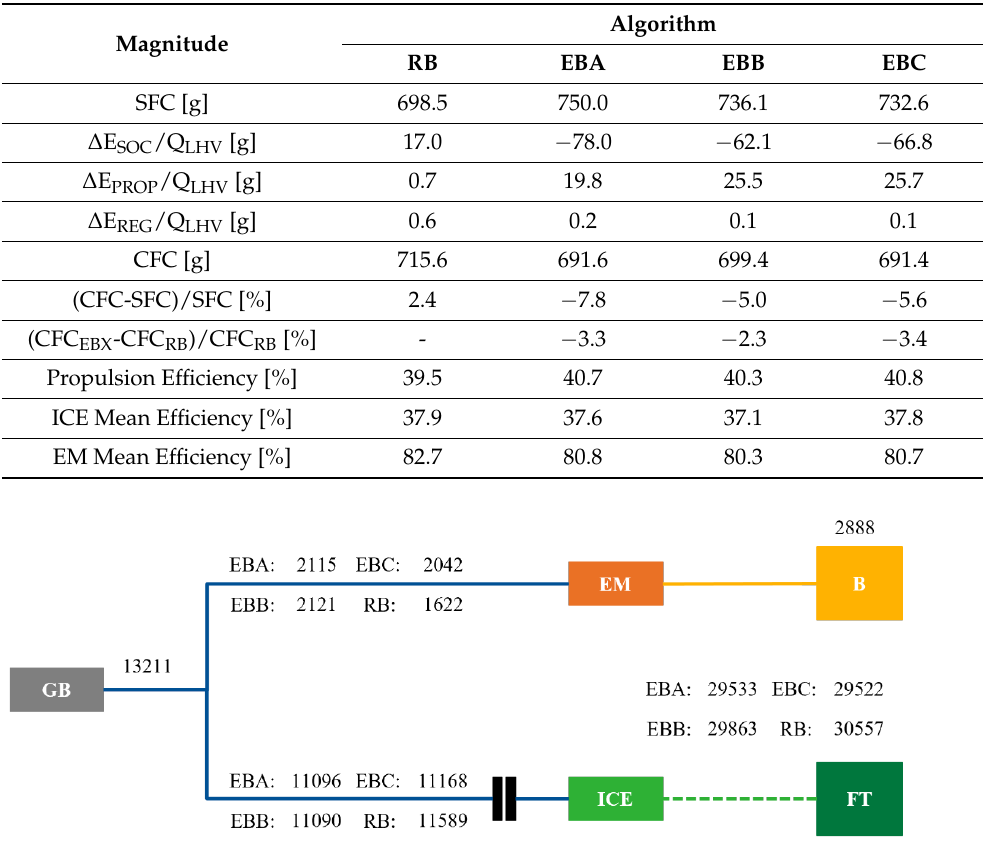
Table 6. Consumption and mean efficiency values of the main powertrain components for WLTC. Magnitude